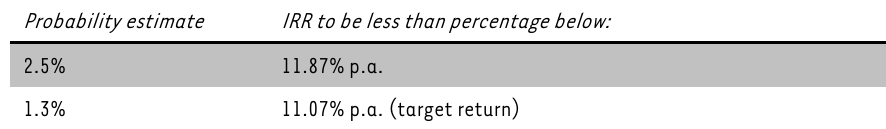
TABLE 13: Probabilities of downside IRRs of investments in Set E Probability